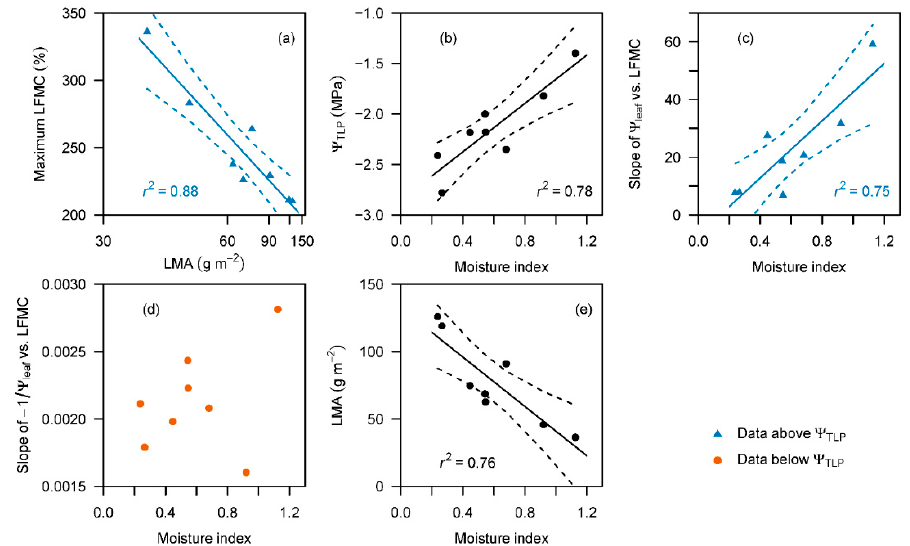
Figure 5. Relationship between ( a ) maximum live fuel moisture content (LFMC) and average leaf mass per area (LMA) in eight Eucalyptus species in a common garden experiment; and ( b – e ) plant ecophysiological traits and the moisture index from the climate of origin (calculated as the ratio of precipitation to potential evapotranspiration), including ( b ) the turgor loss point ( Ψ TLP ), ( c ) the slope of Ψ leaf versus LFMC above the Ψ TLP (analogous to cell wall elasticity), ( d ) the slope of − 1 / Ψ leaf versus LFMC below the Ψ TLP (analogous to osmotic potential at full hydration), and ( e ) average LMA. Note, the same LMA values are used in ( a , e ), but the data are transformed by a negative reciprocal transformation in ( a ). Dashed lines represent the 95% confidence interval of each regression.